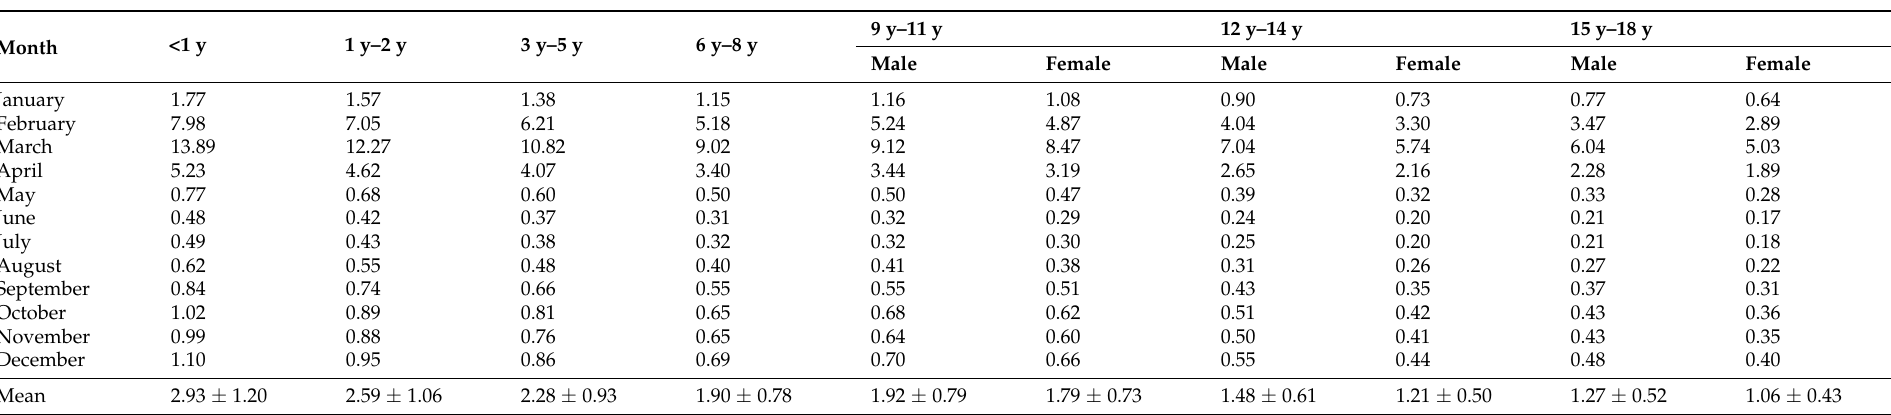
Table 4. Mean of the monthly means of the HQ related to PM 2.5 according to the different age groups of children during